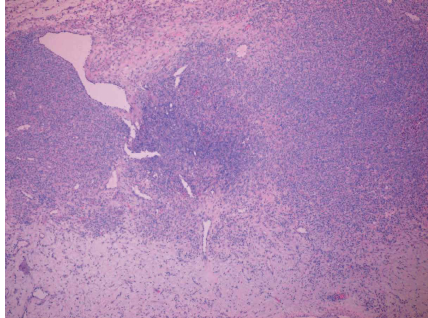
Figure 3: (40x, H&E) Pseudolobular pattern with variable cellularity and edema.